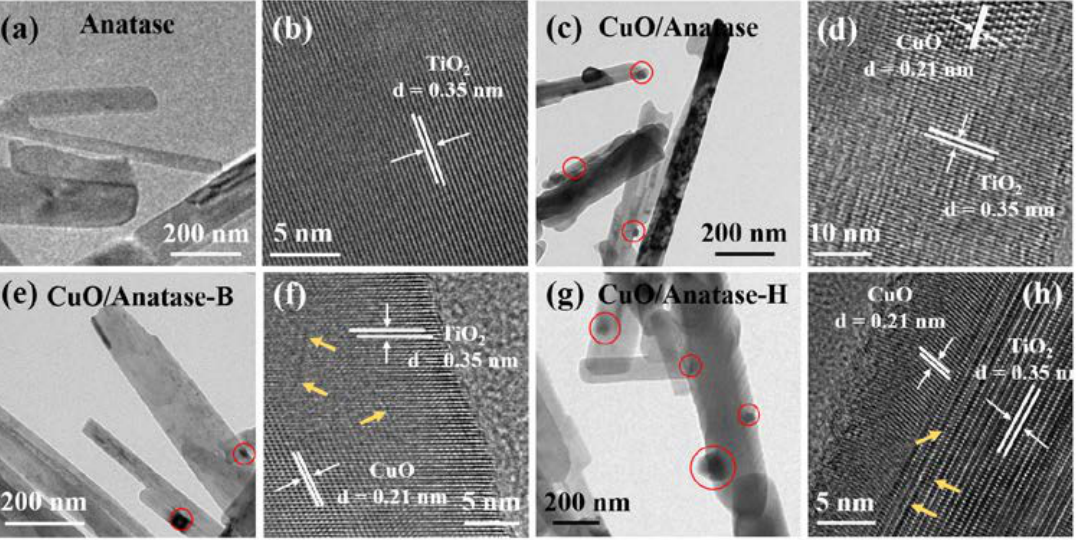
Figure 4. The ( a , b ) TEM and HRTEM images of anatase, ( c , d ) TEM and HRTEM images of CuO/anatase, ( e , f ) TEM and HRTEM images of CuO/anatase-B and ( g , h ) TEM and HRTEM images of CuO/anatase-H catalyst (red circles: CuO nanoparticles; yellow arrows: distortions of lattice fringes).